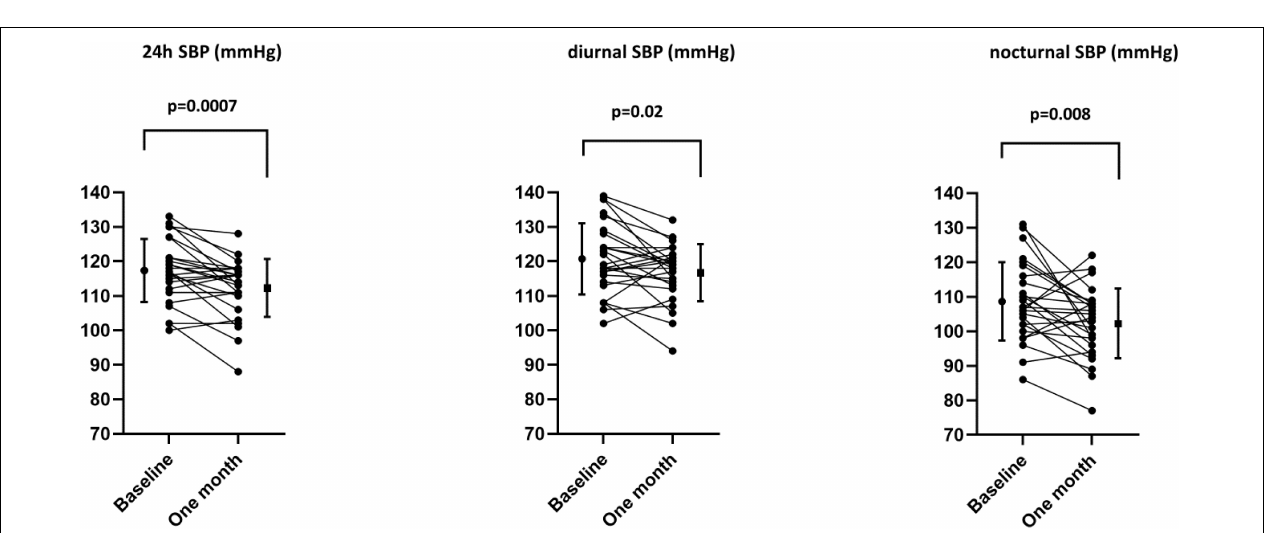
FIGURE 2 | Individual variations in 24 h, diurnal, and nocturnal systolic blood pressure with empagliflozin.